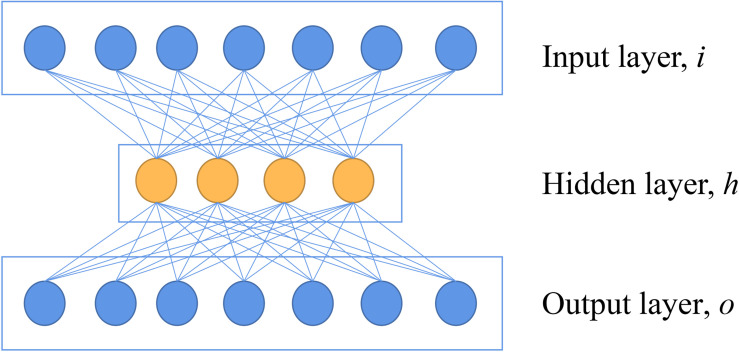
The basic architecture of autoencoder.